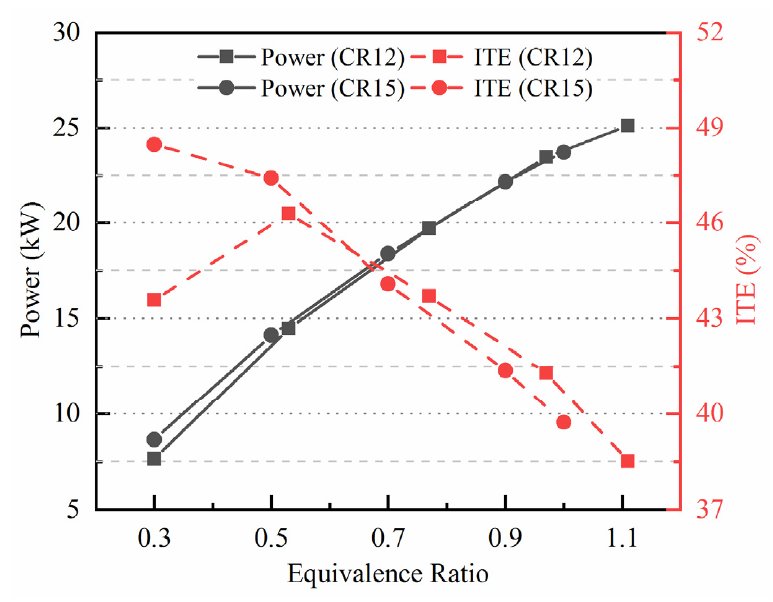
Figure 5. Power and indicated thermal efficiency (ITE) at different equivalence ratios [48].